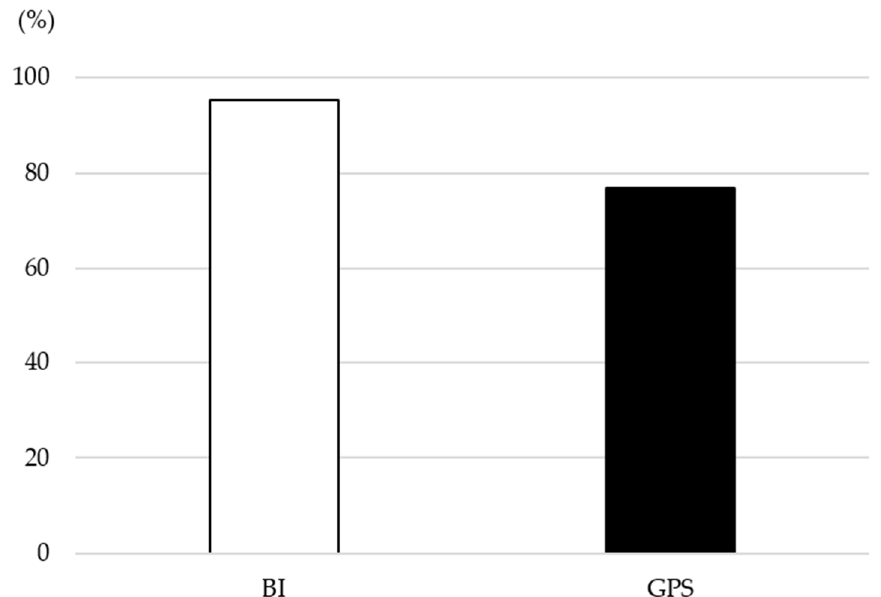
Figure 1. Screening rates according to the BI and GPS. BI: Barthel Index, GPS: Glasgow Prognostic Score. Table 1. Baseline characteristics of the study population.